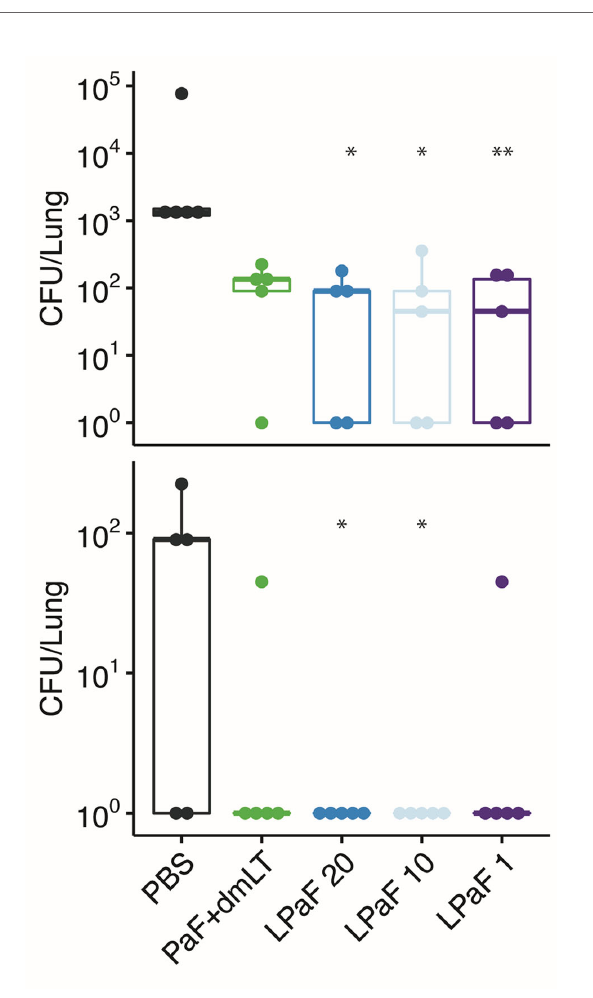
FIGURE 10 | Protective ef fi cacy of antigen formulations against a second Pa challenge strain in mice. Mice (n=10) vaccinated with PBS, PaF (20 µg) admixed with dmLT (2.5 µg) or with 20, 10 or 1 µg of L-PaF on days 0, 14, 28. On day 56, the mice were then challenged IN with PA15808959 and CFU/lung determined on days 2 (top) and 3 (bottom) (n=5 on each day). The 10 -1 and 10 0 designations are the same as in Figure 4 . In all cases, the black line indicates the mean counts for the group. Signi fi cance was calculated by comparing antigen containing groups to the PBS group with Dunnett ’ s multiple comparisons tests. *p < 0.05; **p <